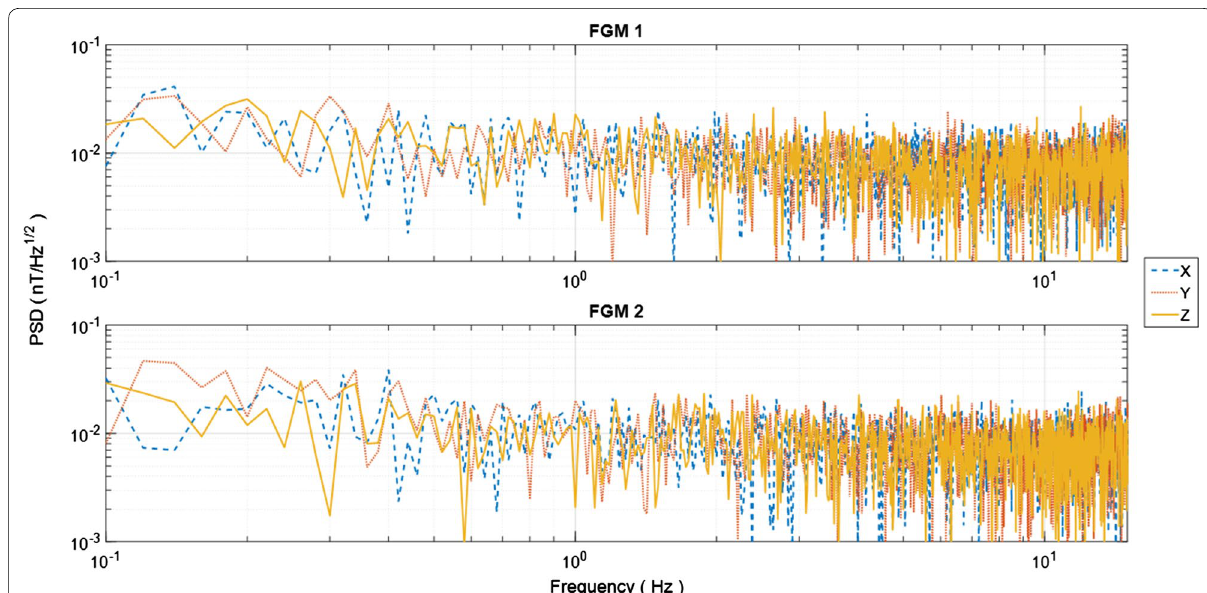
Fig. 18 In-orbit noise Power Spectral Density (PSD) of FGM1 and FGM2. The data are high-pass filtered with a cut-off frequency of 0.1 Hz and the solar wing does not